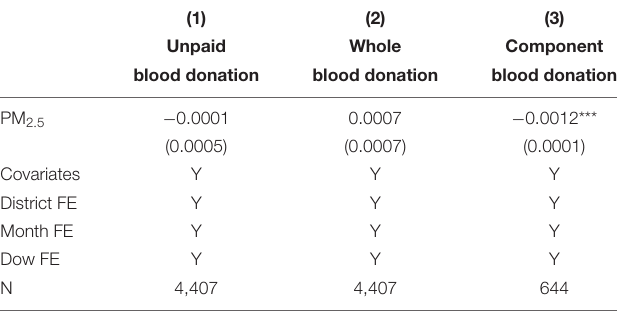
TABLE 3 | Main results of Poisson